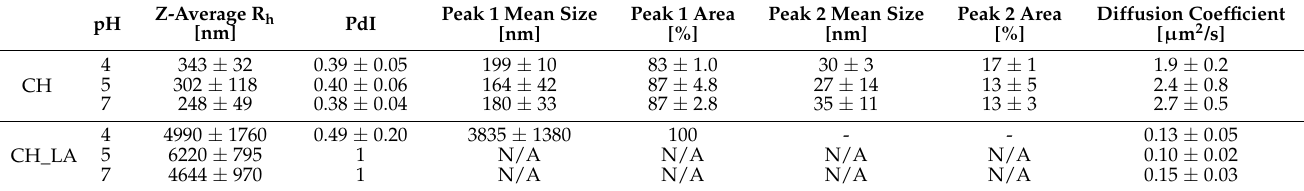
Table 3. Z-average hydrodynamic radius, size distribution and diffusion coefficient of CH and CH_LA in medium with different